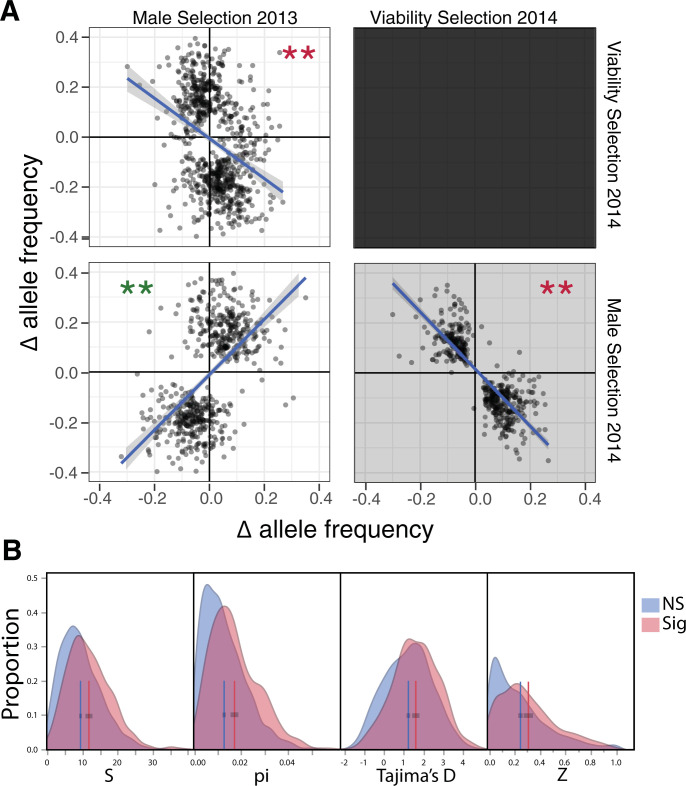
(A) Pairwise contrasts between predicted changes owing to male selection in 2013, viability selection in 2014, and male selection in 2014. A single SNP per gene is reported (the most significant) if p < 10−5. The SNPs ascertained for contrasts are distinct from those for tests in isolation (Fig 4), although these SNP sets are overlapping (see S5 and S9 Tables). (B) Density plots for molecular test statistics are depicted for 587 selected-SNP windows and 2751 control windows. Vertical lines are means. The number of polymorphisms (S), nucleotide diversity (pi), and Tajima’s D are based on the flanking DNA (100 bp on each side, but not including the focal SNP). Z focal is Zns calculated by contrasting the focal SNP to all flanking SNPs.